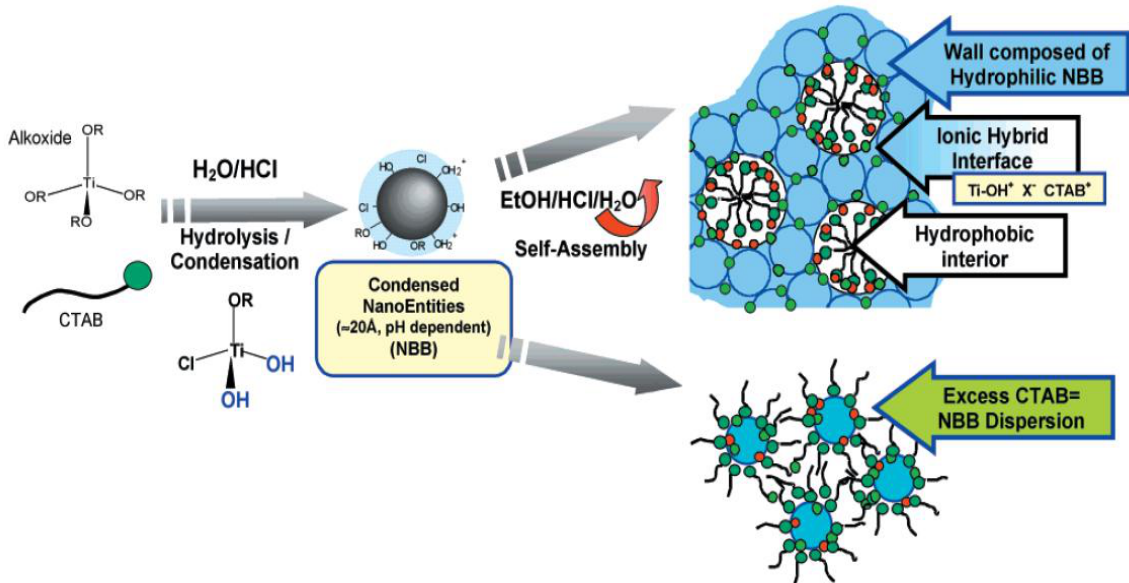
Figure 6. Figure depicts the synthesis of mesoporous TiO cetyltrimethylammonium bromide (CTAB) surfactant. Reprinted with permission from